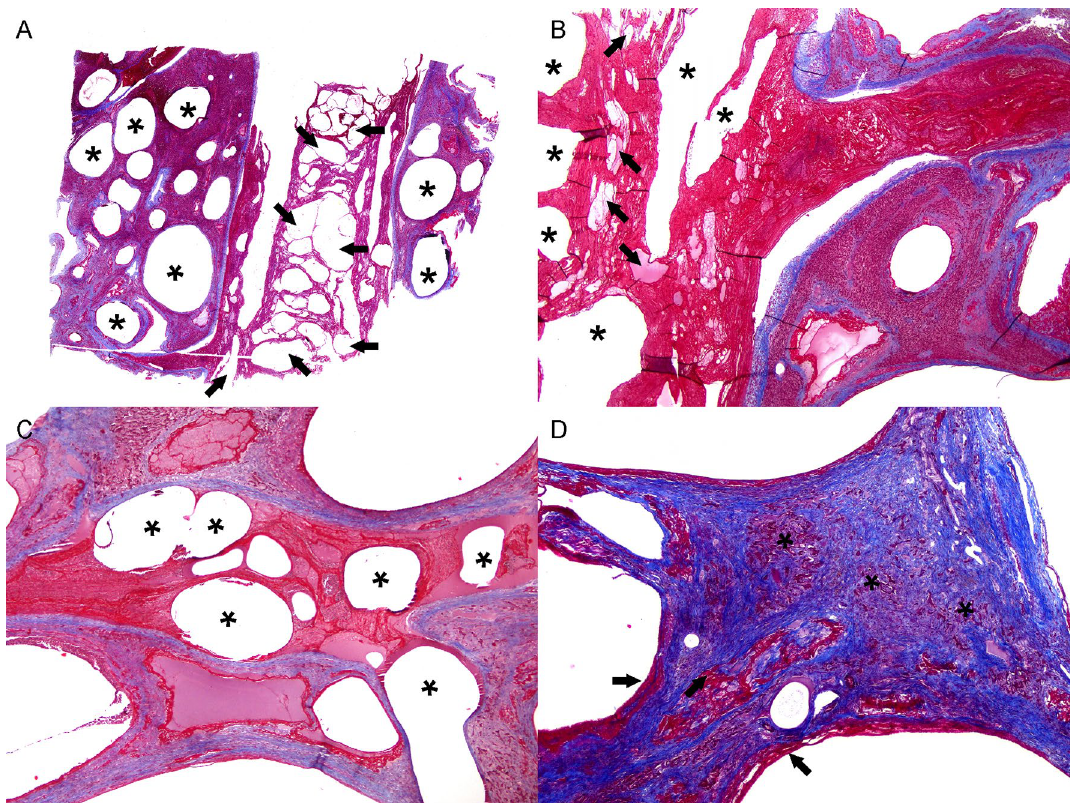
Figure 3. Histochemical features of cystic liver lesions in dolphins. ( A ) Case 4. low magnification of moderate caliber hepatic vein with an obliterative thrombus. The latter contains numerous cystic spaces (arrows). Adjacent hepatic veins are cystically dilated (asterisks). ( B ). Case 4. Higher magnification of obliterative fibrin thrombus in shown in ( A ). Note large organizing and branching fibrin layering and strands admixed with small pockets with serum protein (arrows) and cystic spaces (asterisks). ( C ) Case 4. Additional poorly organized fibrin thrombi with cystic spaces (gas bubbles; asterisks) expanding serum protein, erythrocytes and fibrin. ( D ) Case 4. Representative chronic cystic liver lesion characterized by fibrous connective tissue (blue), minimal marginal fibrin (arrows), and atrophic hepatic cords